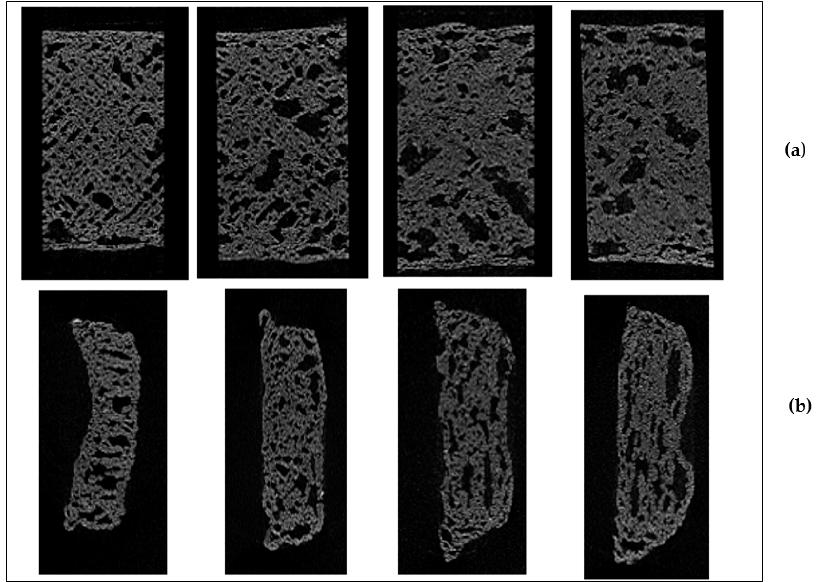
Figure 7. Representative images of ( a ) top view of reconstructed cross-sectional Micro CT images of baked cookies with 50%, 70%, 90%, and 100% fill density. ( b ) Cross-sectional view of reconstructed cross-sectional Micro CT images of baked cookies with 50%, 70%, 90%, and 100% fill